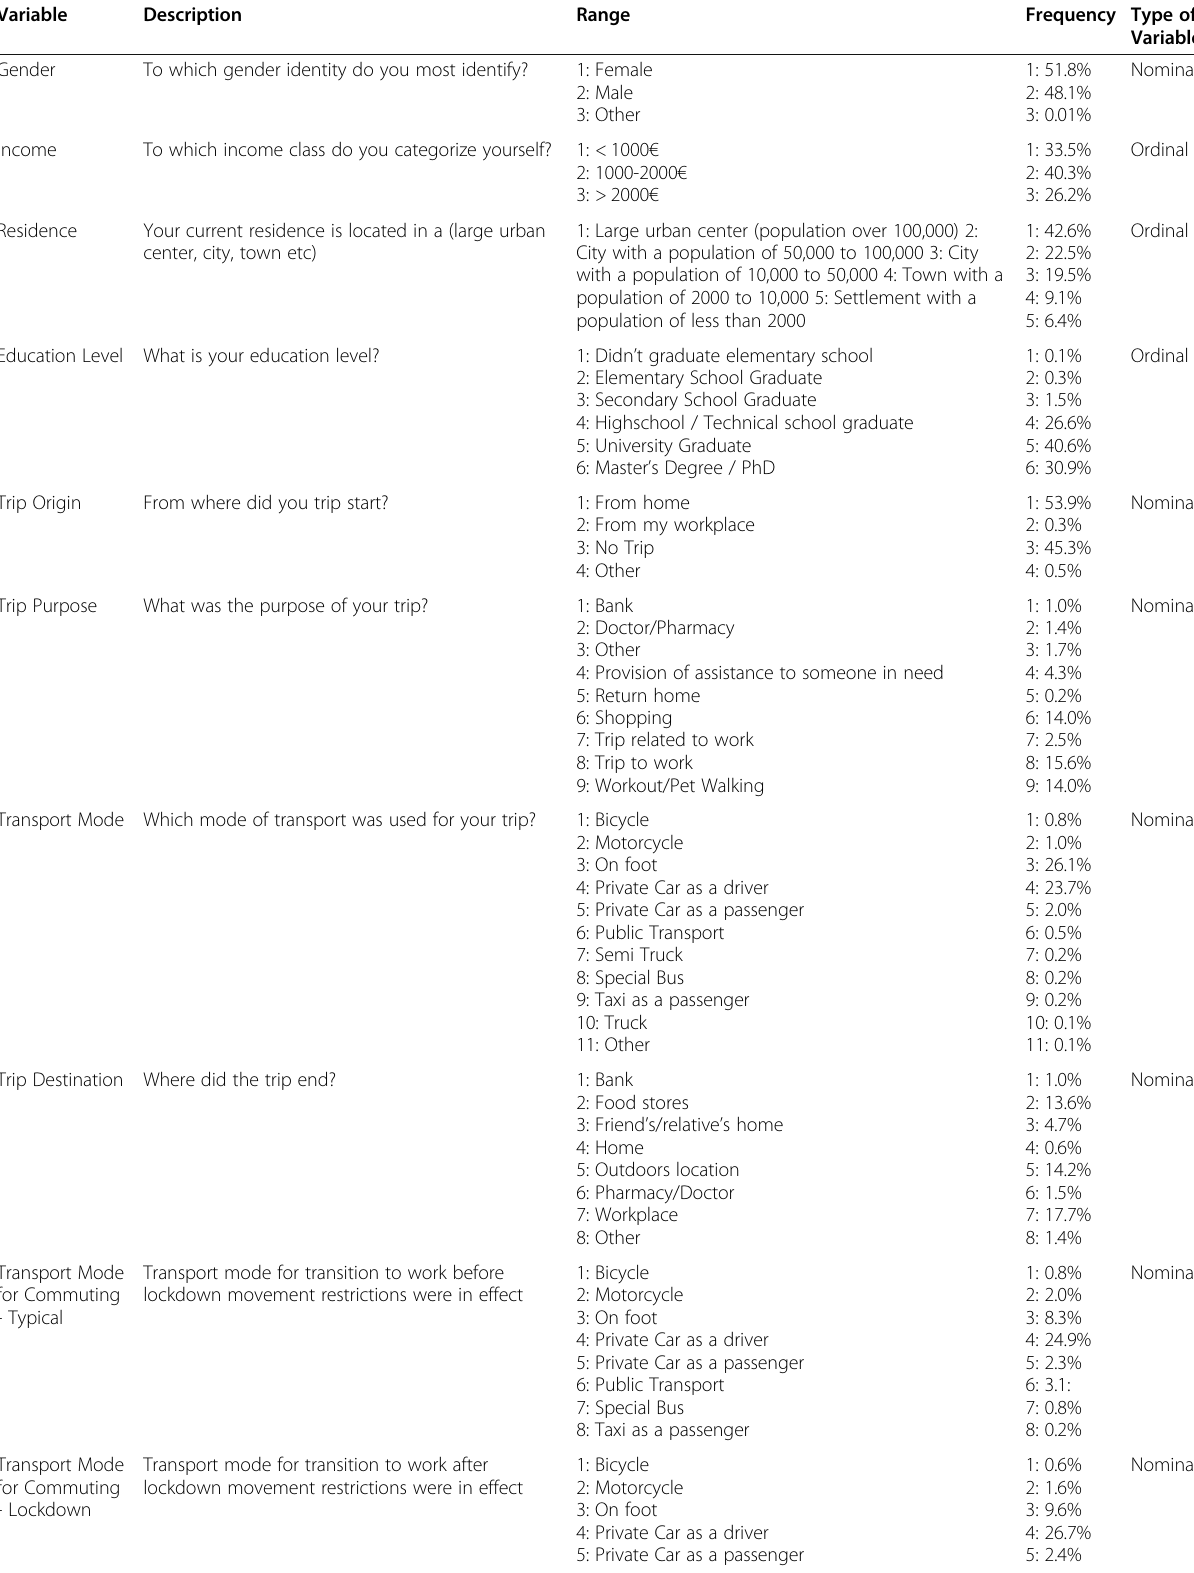
Table 6 Descriptive characteristics of main nominal/ordinal